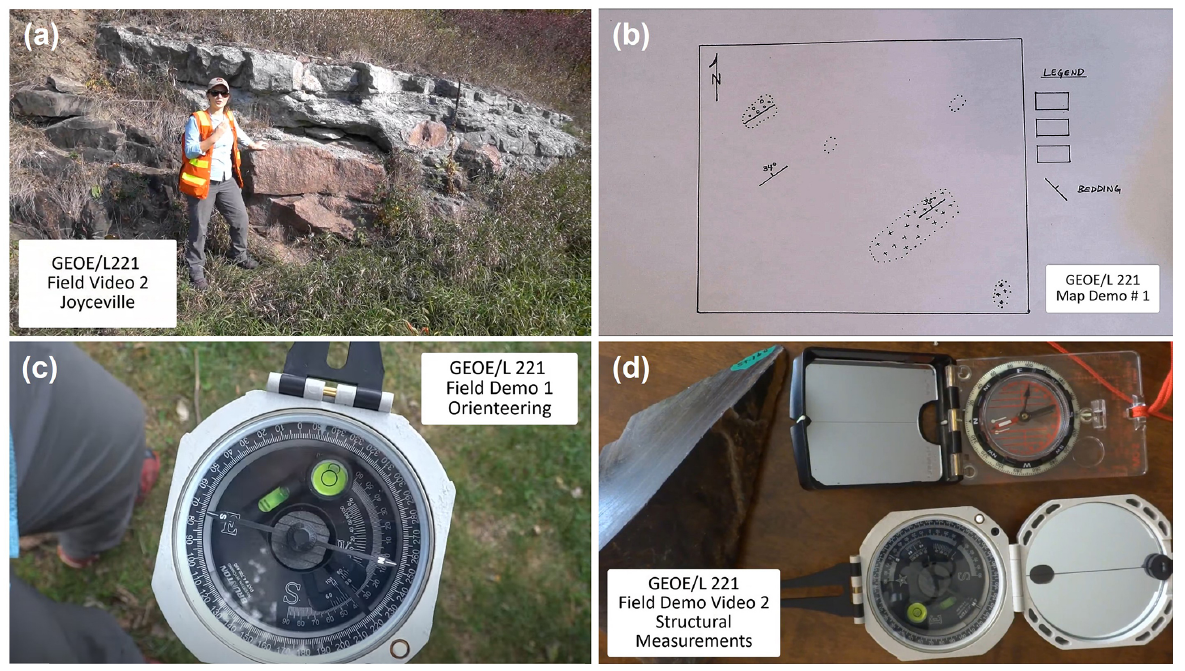
Figure 3. Examples of video-recorded course content. (a) One of five field videos at a Kingston area outcrop. (b) One of three map demon- stration videos. (c) Field demonstration video on orienteering. (d) Demonstration video on measuring orientations of planar and linear structural features (strike/dip and trend/plunge, respectively).